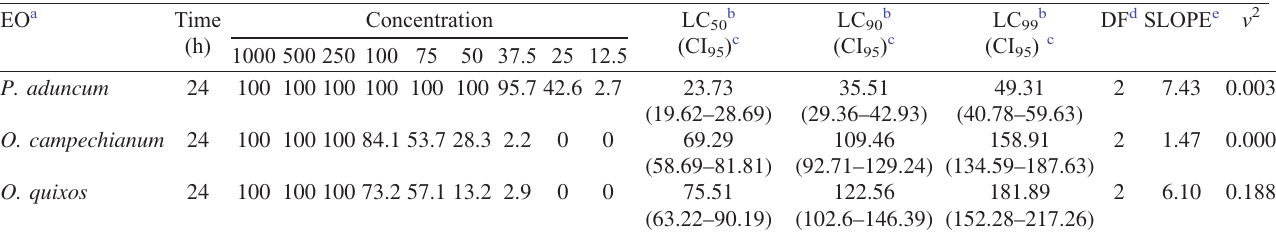
Table 2. Larvicidal effect of Piper aduncum, Ocimum campechianum and Ocotea quixos essential oils on Aedes aegypti at different concentrations, after 24 h of exposure, expressed as percentage of